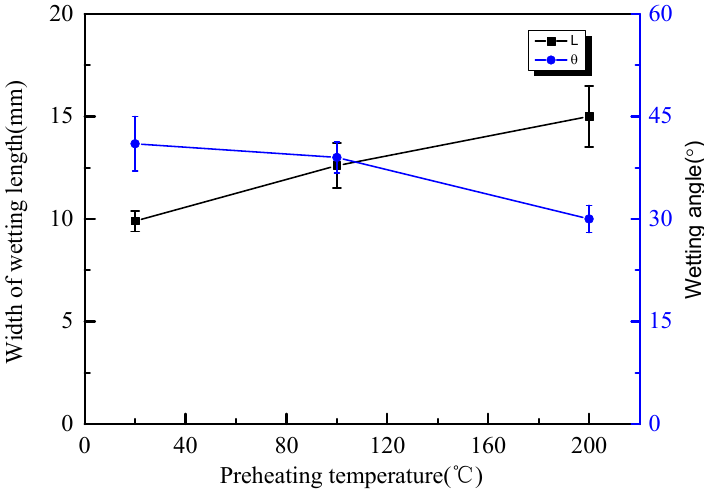
Figure 5. Width of wetting length and wetting angle at different preheating temperatures.